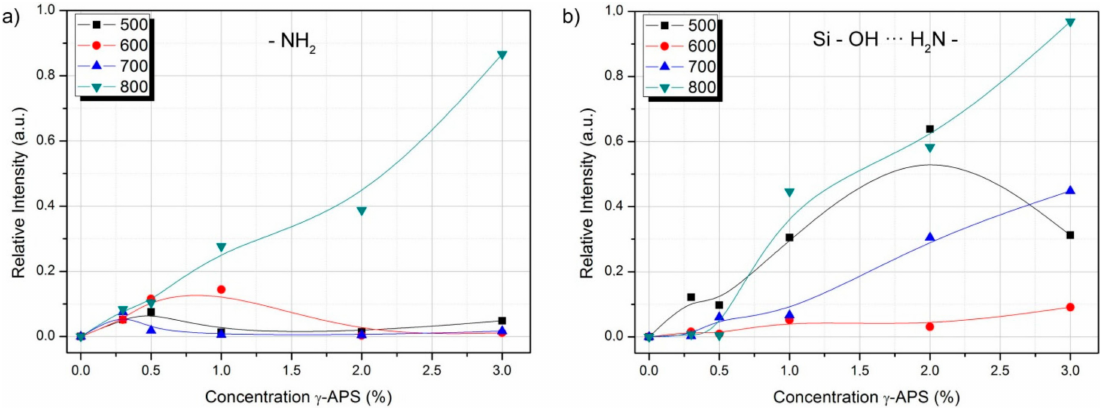
Figure 9. Relative intensity of the IR bands after spectral deconvolution. It is shown the relative intensity of the bands corresponding to ( a ) free amino groups and ( b ) amino groups interacting (weak interaction) with silanol